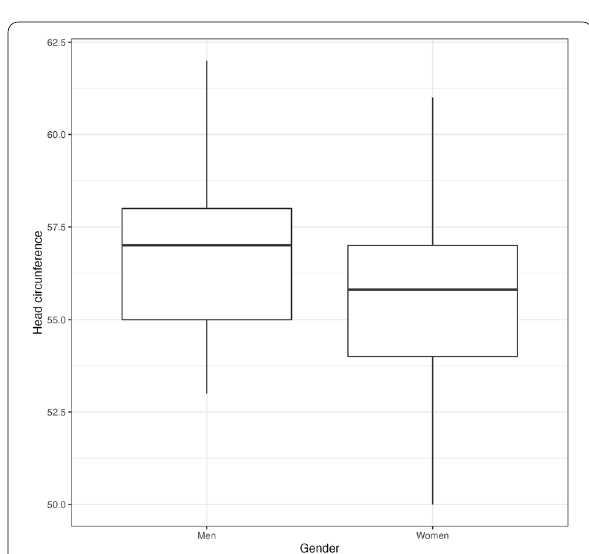
Fig. 4 Head circumference among